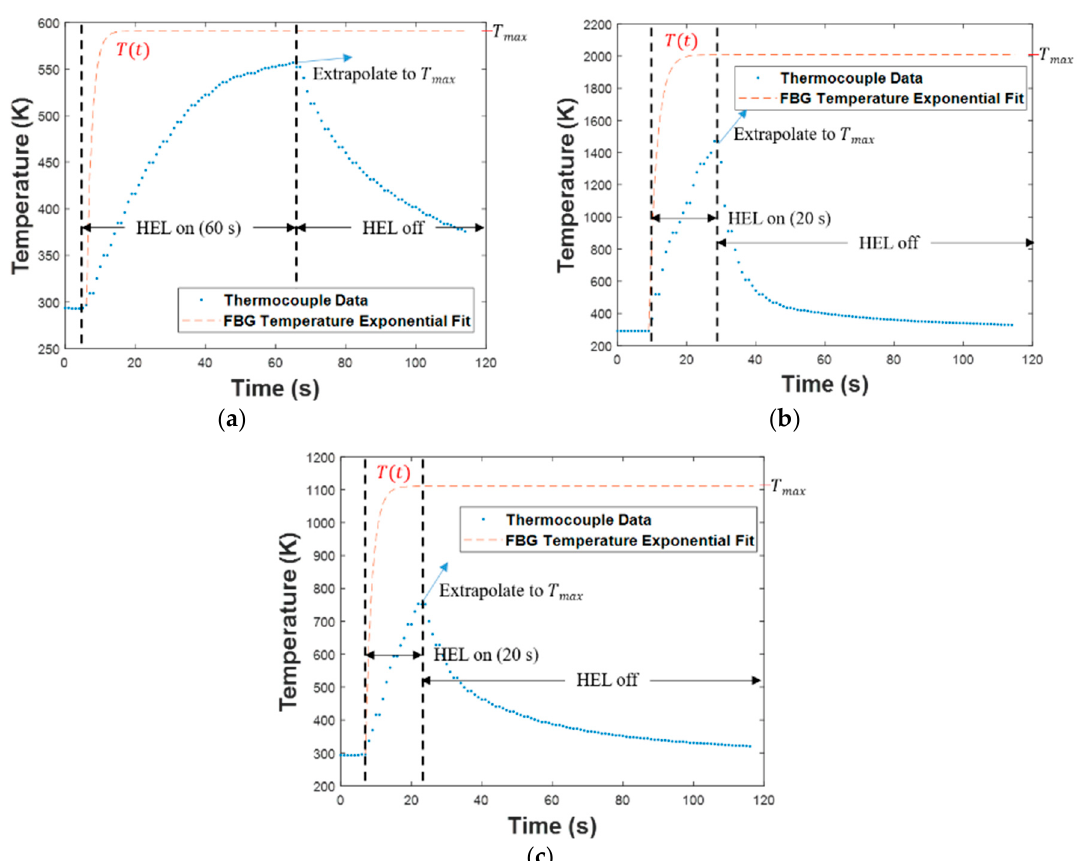
Figure 4. Two-dimensional plot of reflected spectrum over time during HEL tests: ( a ) FBG slightly degraded, ( b ) FBG moderately degraded, and ( c ) FBG severely degraded.